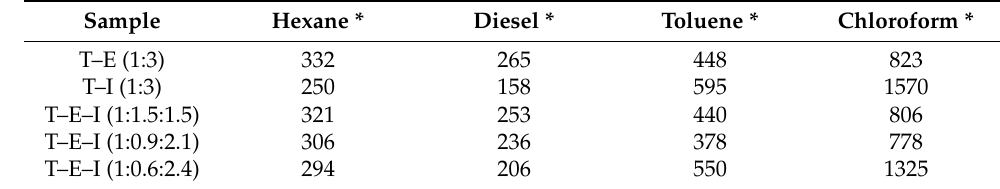
Table 4. Absorption properties of organic solvents of the prepared polyHIPEs. Sample Hexane * Diesel * Toluene